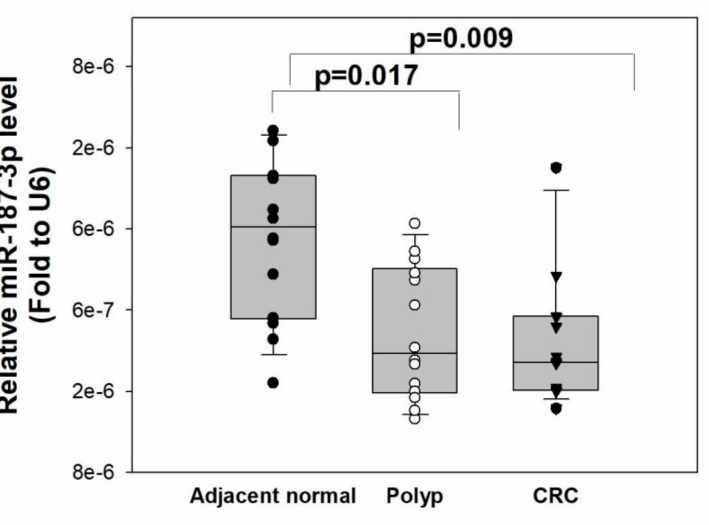
Figure 1. MiR-187-3p was repressed in colorectal polyp and CRC tissues: MiR-187-3p levels were determined in synchronous polyp, CRC, and normal mucosa samples from 14 patients by quan- titative RT-PCR. MiR-187-3p was significantly repressed in polyp ( p = 0.017) and CRC ( p = 0.009) tissues when compared to adjacent normal tissue. No significant difference was observed between polyp and CRC tissues. The level of miR-187-3p was expressed as 2 ( − delta Ct[miR-187-3p–U6]) . Ex- periments were performed in duplicate, and the data are expressed as the mean ± SEM of three independent